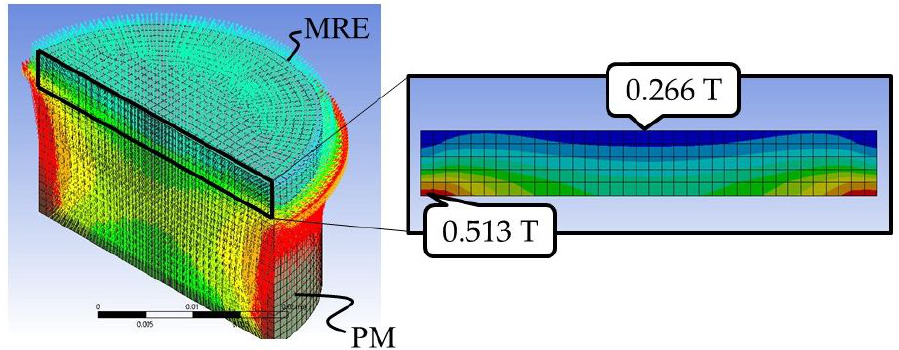
Figure 7. Result of the finite-element method (FEM) analysis. Left: vector field of the magnetic flux density. The front surface shows a half-cut surface. Right: contour view of the absolute value of the flux density on the cut surface of the MRE. The bottom line represents the contact surface with the magnet via a plastic plate. These figures show the MF is axially symmetric, but non-uniform in the vertical direction.